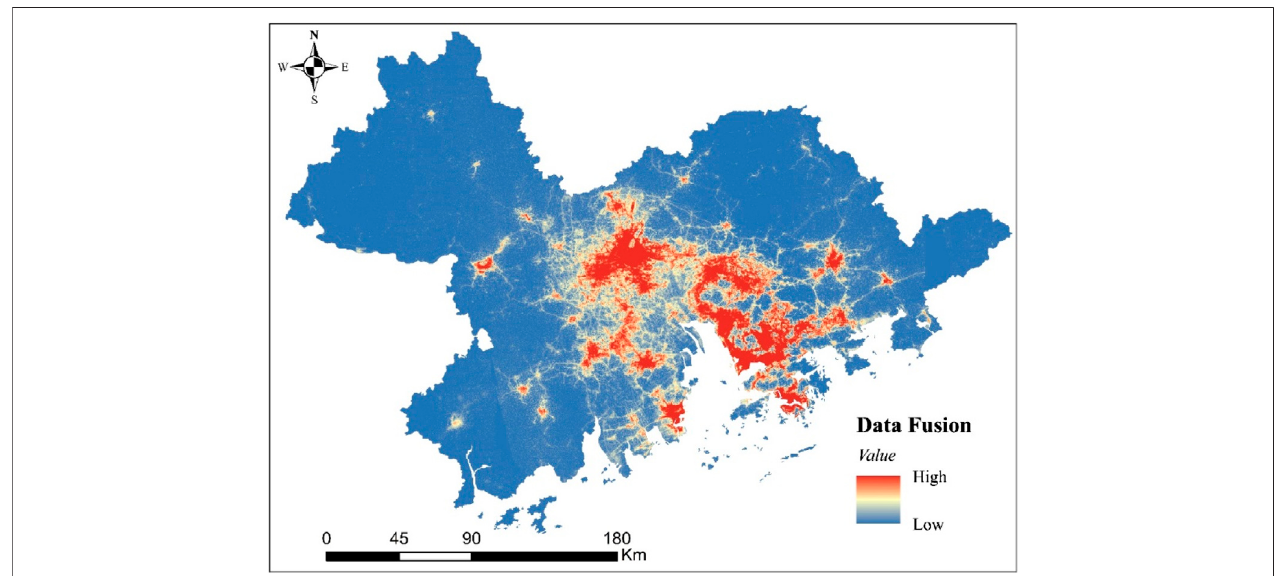
FIGURE 6 | Data fusion results of NTL and TL